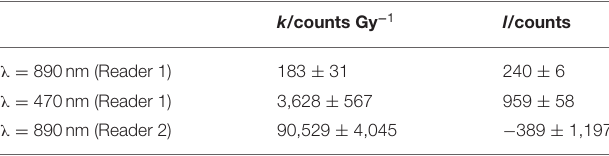
TABLE 3 | Parameters obtained from the calibration curves for infrared (Reader 1 and Reader 2) and blue light stimulation (Reader